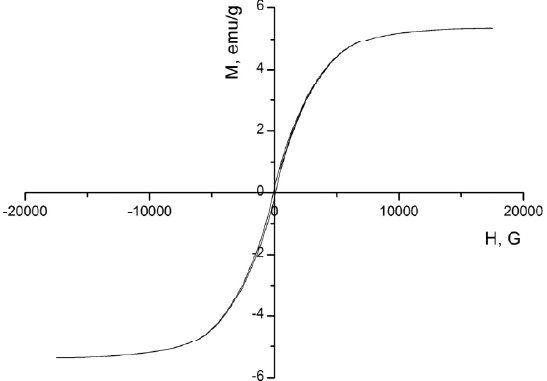
Fig. 2. Magnetization diagram for MCM-41/ Fe (sample